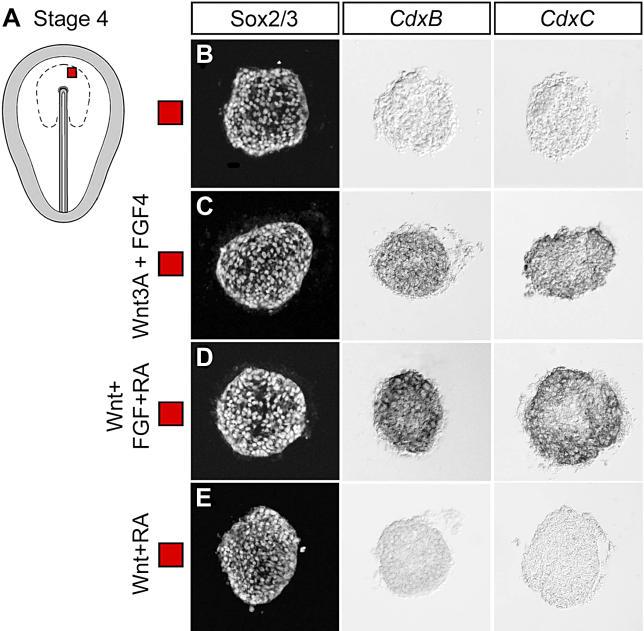
Wnt and FGF, in Combination, Induce
Cdx Gene Expression in Prospective FB Cells
(A) Schematic drawing of a stage 4 embryo. Dotted line indicates the presumptive neural plate. Red box indicates prospective FB explants used for in vitro studies.(B–D) Sox2 and Sox3, in combination, were used as general presumptive neural markers. Each row represents consecutive sections from a single explant.(B) Control stage 4 FB explants generated Sox2
+/3
+ but no
CdxC
+/CdxB

+ presumptive neural cells (
n = 24 explants).
(C) Stage 4 FB explants cultured in the presence of Wnt (˜150 ng/ml) and FGF (60 ng/ml) simultaneously generated
CdxC
+
/CdxB
+ presumptive caudal neural cells (
n = 26 explants).
(D) 4 FB explants cultivated in the presence of Wnt3A (˜150 ng/ml), RA (10 nM), and FGF (30 ng/ml) generated
CdxC
+
/CdxB
+ presumptive caudal neural cells (
n = 18 explants).
(E) 4 FB explants cultivated in the presence of Wnt3A (˜150 ng/ml) and RA (10 nM) did not generate
CdxC
+
/CdxB
+ presumptive caudal neural cells (
n =14 explants).